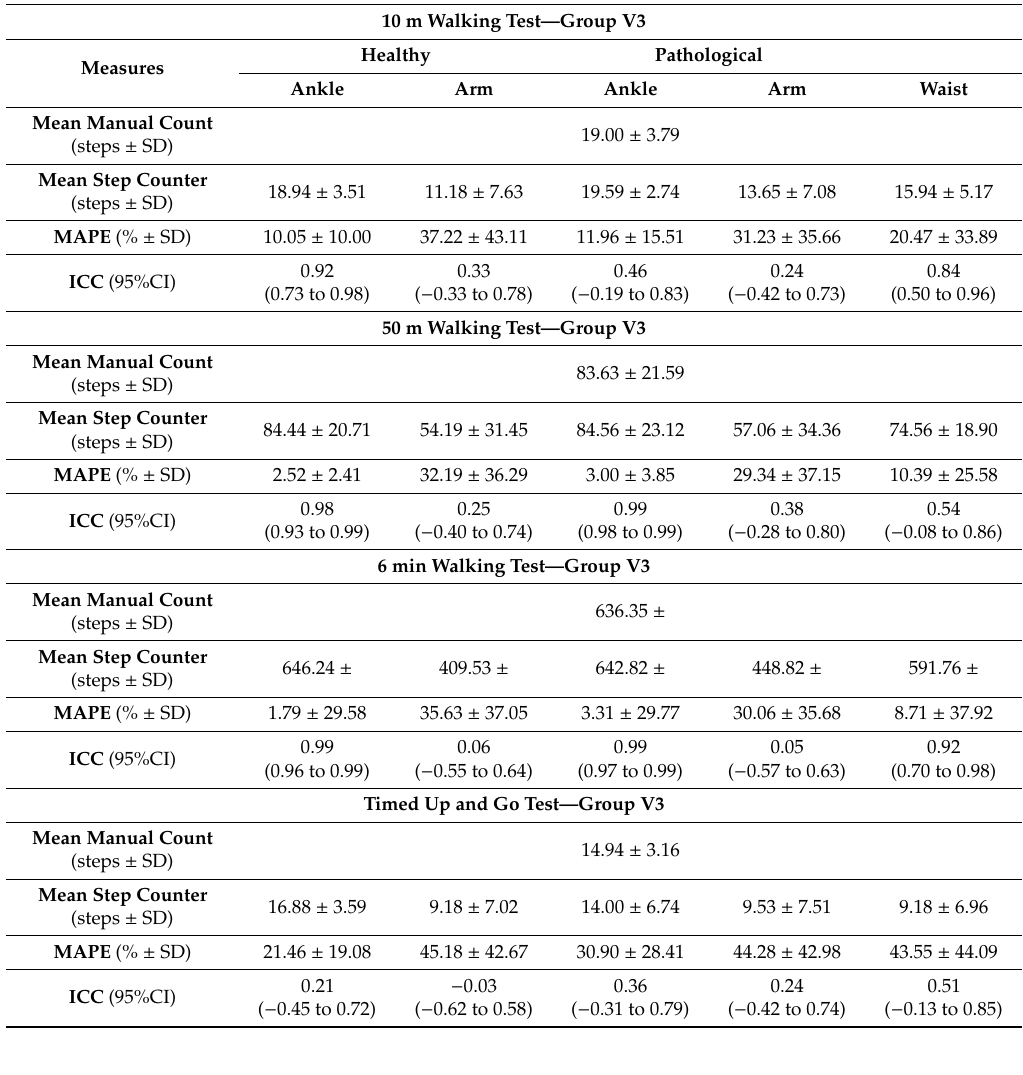
Table 4. Mean absolute percentage error and intraclass correlation coe ffi cient of manually counted steps and steps counted using step counters in di ff erent positions in group V3.